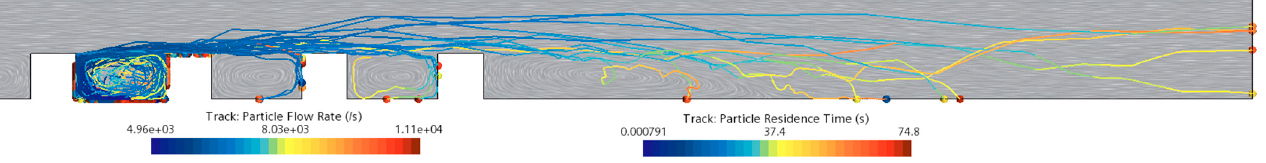
Figure 6. Percentage of the particles (expressed as mass) deposited in different locations in the do- main for all the geometrical and flow configurations. The abbreviation ST stands for street canyon. Note the logarithmic Z scale. This is due to large differences in the percentage of particle dispersion in the domain. For H/W = 1, no particles were deposited in ST3. It is evident that most of the particles are deposited on the ground of the first street canyon. The particles released from the parts where 𝑢 ∗ has a lower value are also show- ing the minimal residence time. The second highest value of the deposited particles is on the sides of the street canyon. A significant amount of particles are also deposited on the roofs and the outer region. Fewer particles made it to the second and third street canyon. With an increasing wind speed, more particles are dispersed outside the surface. Addi- tionally, more particles are deposited on the sides, the second street canyon, roofs, and the outer region. An exception is the configuration H/W = 1, where with an increasing wind speed, the amount of particles in the second canyon and the outer region decreases. This shows that, in almost every case, a higher wind speed causes better ventilation of the can- yon. Ventilation can be expressed as the amount of particles (here, originated in resuspen- sion) leaving the first street canyon. This was also confirmed by [38]. More interesting are